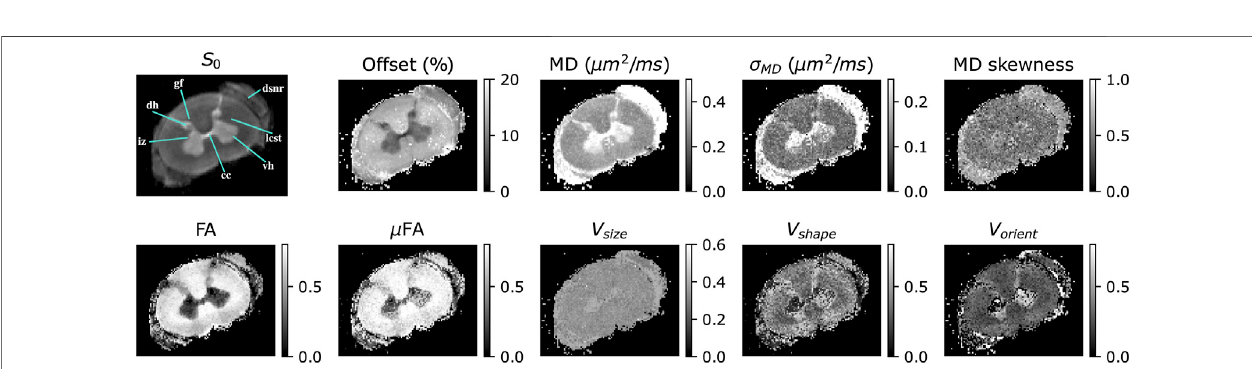
FIGURE 4 | DTD derived stains obtained in a excised cervical spinal cord of macaque monkey showing microscopic anisotropy and heterogeneity. The following regionsofinterestinthespinalcordarehighlightedinthenon-diffusionweightedimage( S 0 ):iz — intermediatezone,dh — dorsalhorn,gf-gracilefasciculus,dsnr — dorsal spinal nerve root, lcst — lateral corticospinal tract, vh — ventral horn and cc — central canal. The DTD stains include the signal offset, ε , expressed as percent of S 0